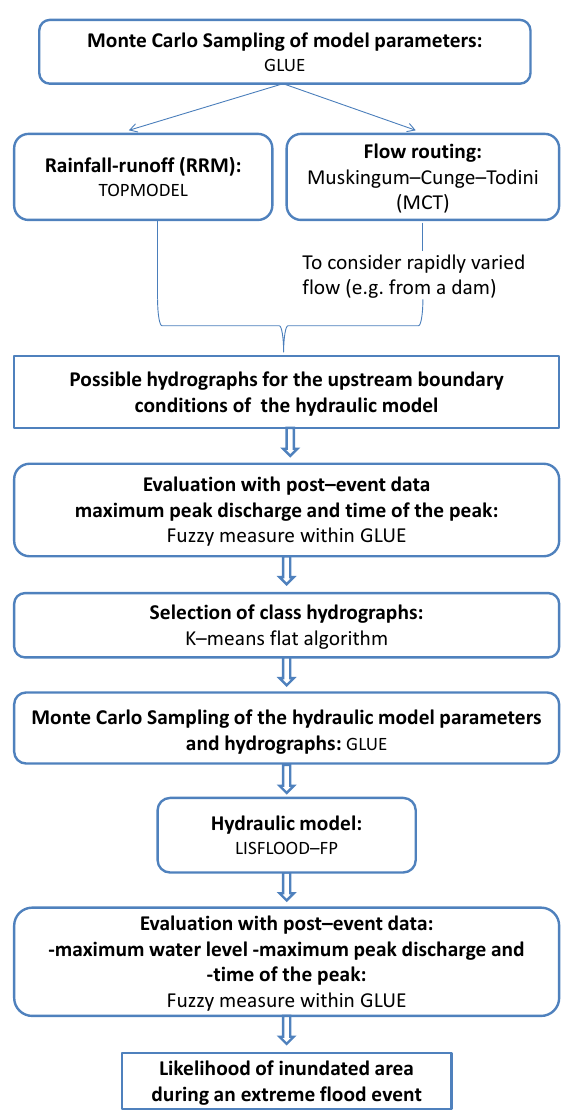
Figure 5. Scheme of the modelling framework used to reproduce an extreme flood event using post-event-estimated data to drive and constrain a combination of modelling tools within an uncertainty- analysis